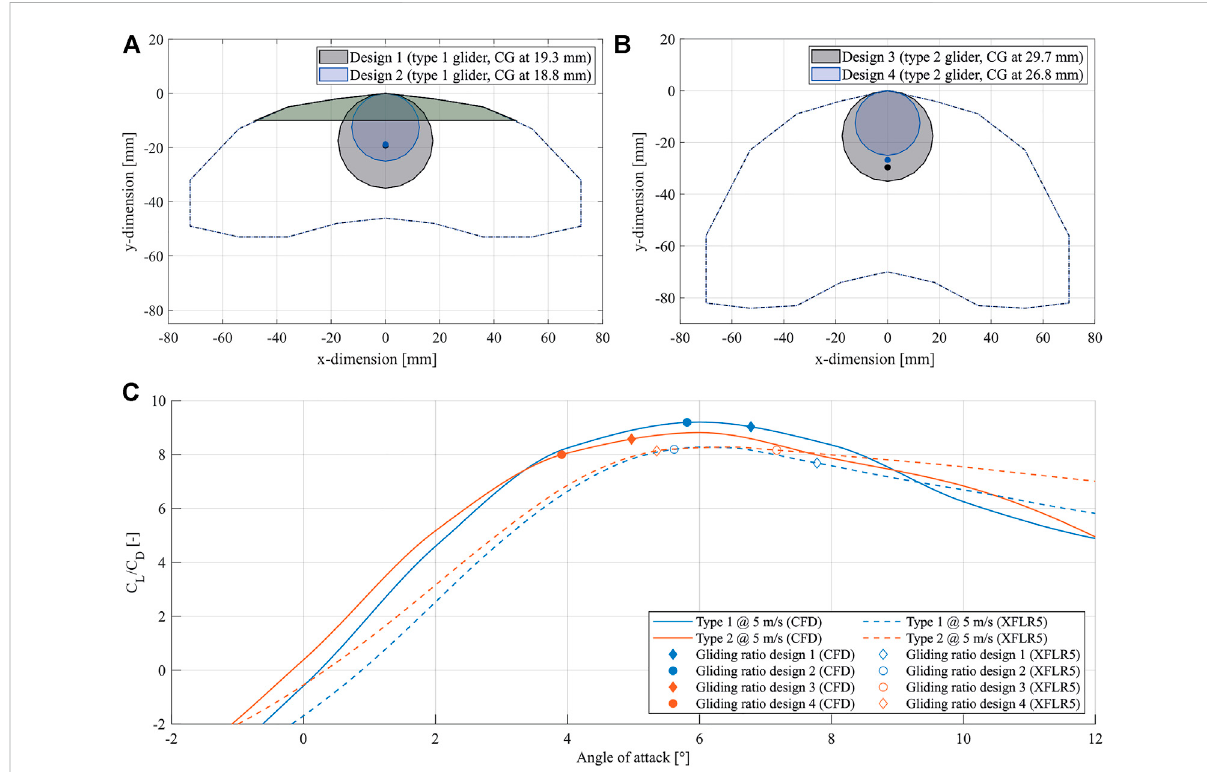
FIGURE 4 Overview of the glider ’ s shape and fl ight performance. (A) represents the slender wing of the glider type 1 with the two tested center of gravity indicated.Thedistanceofthecenterofgravityfromtheleadingedgeisgiven.Thelightgreenareamarksthelocationofadditionalweightthathadto be added to achieve stable fl ight, (B) represents the wide wing of the glider type 2 with the two tested center of gravity marked. The distance of the centerofgravity fromtheleadingedge isgiven, (C) shows the lift / drag ratiosversusangle ofattack fordifferentglider designs.The results using CFD and XFLR5 are